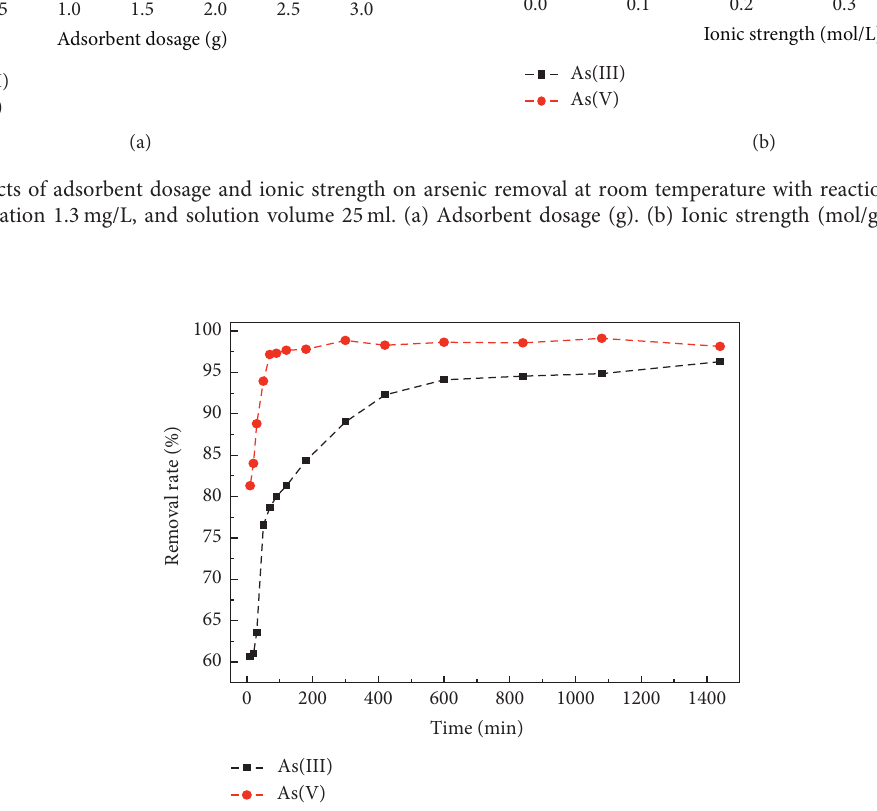
Figure 7: Adsorption kinetics of arsenic at room temperature with reaction conditions: pH � 8, initial As concentration 1.3 mg/L, ionic strength 0.5mol/L, solution volume 25ml, and adsorbent dosage